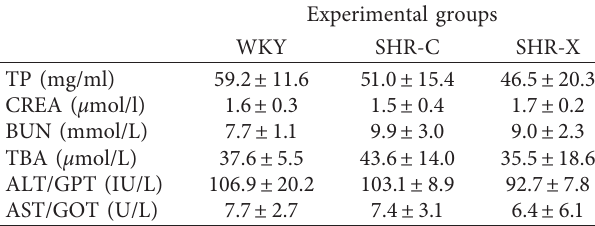
Table 1: The hepatic and renal functions in experimental groups. Experimental